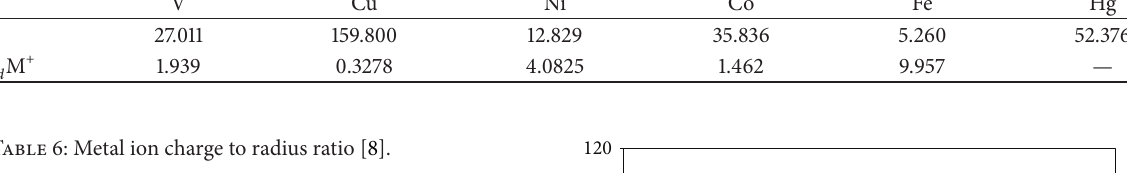
Table 5: Selectivity of mercury at pH 4 in binary mixtures.